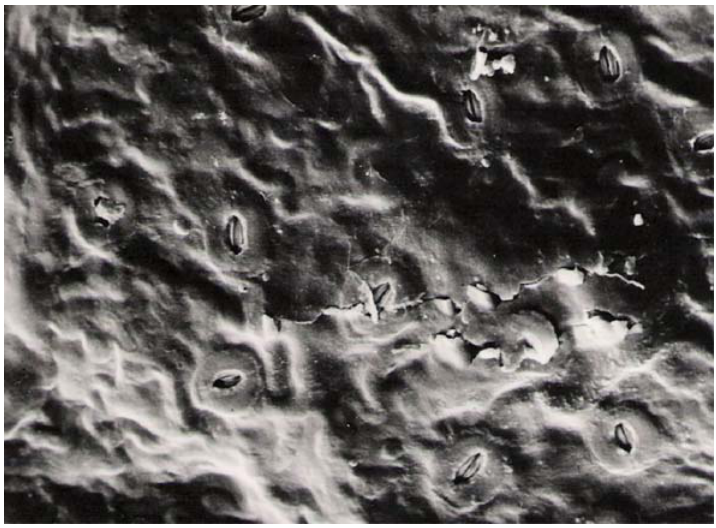
FIGURE 2. Degraded structure of epicuticular waxes, European beech, Vidly, 950 m